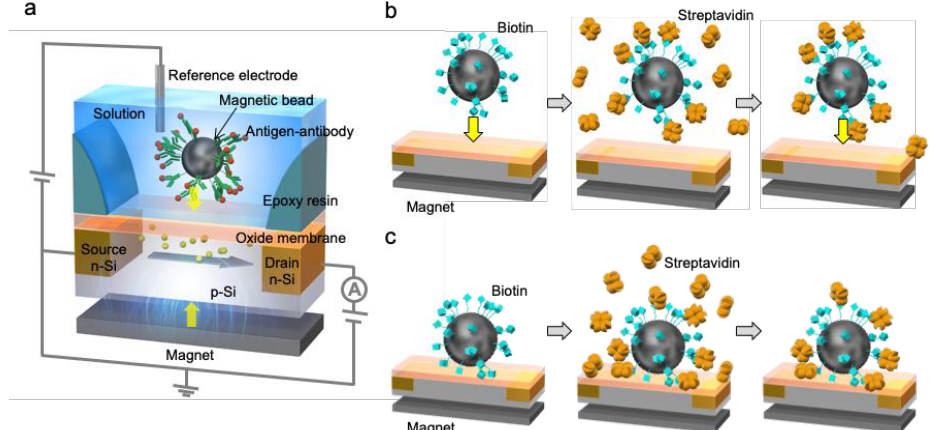
Figure 1. Schematic illustration of the molecular charge contact (MCC)-based ISFET sensor. ( a ) Basic structure of electrical measurement using the MCC-based ISFET sensor. Biomolecular recognition events such as an antigen—antibody reaction occur on magnetic beads but not at the gate insulator of the ISFET. Magnetic beads with biomolecules are made to approach the gate insulator using a button magnet from below the ISFET substrate; ( b ) the previously reported MCC method; and ( c ) the improved MCC method in this